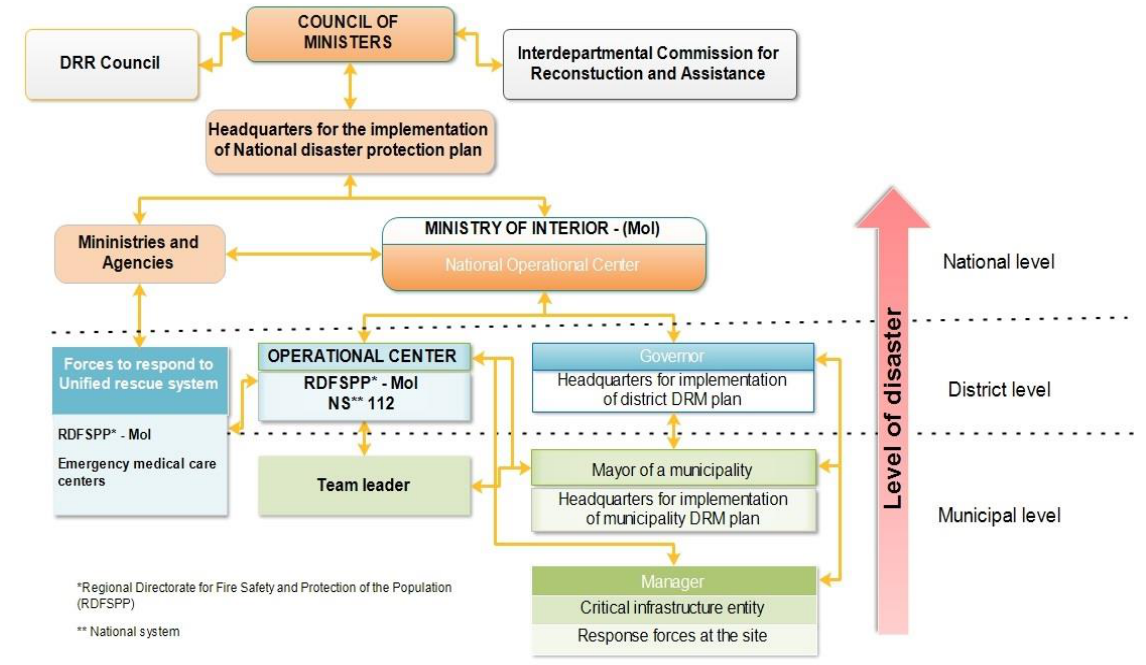
Figure 5. Organisational structure and responsible institutions for DRM in Bulgaria. Partially sourced from [81] (accessed on 25 April 2021).